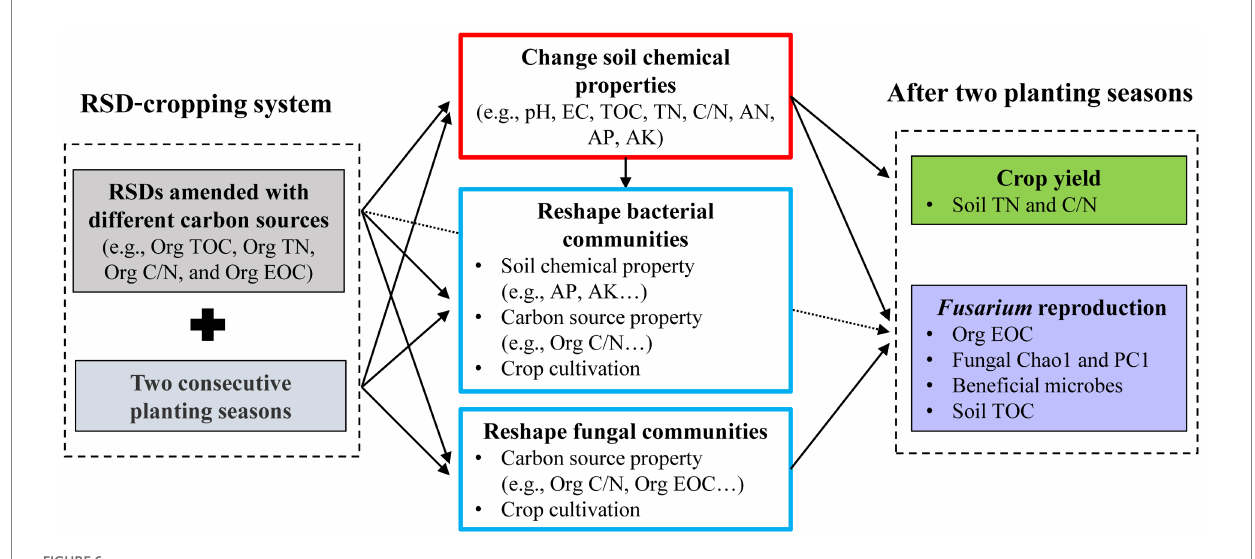
FIGURE 6 Conceptual diagram describing the influence of carbon source on soil microbial community reestablishment, soil chemical properties, pathogen reproduction, and crop performance in a RSD-cropping